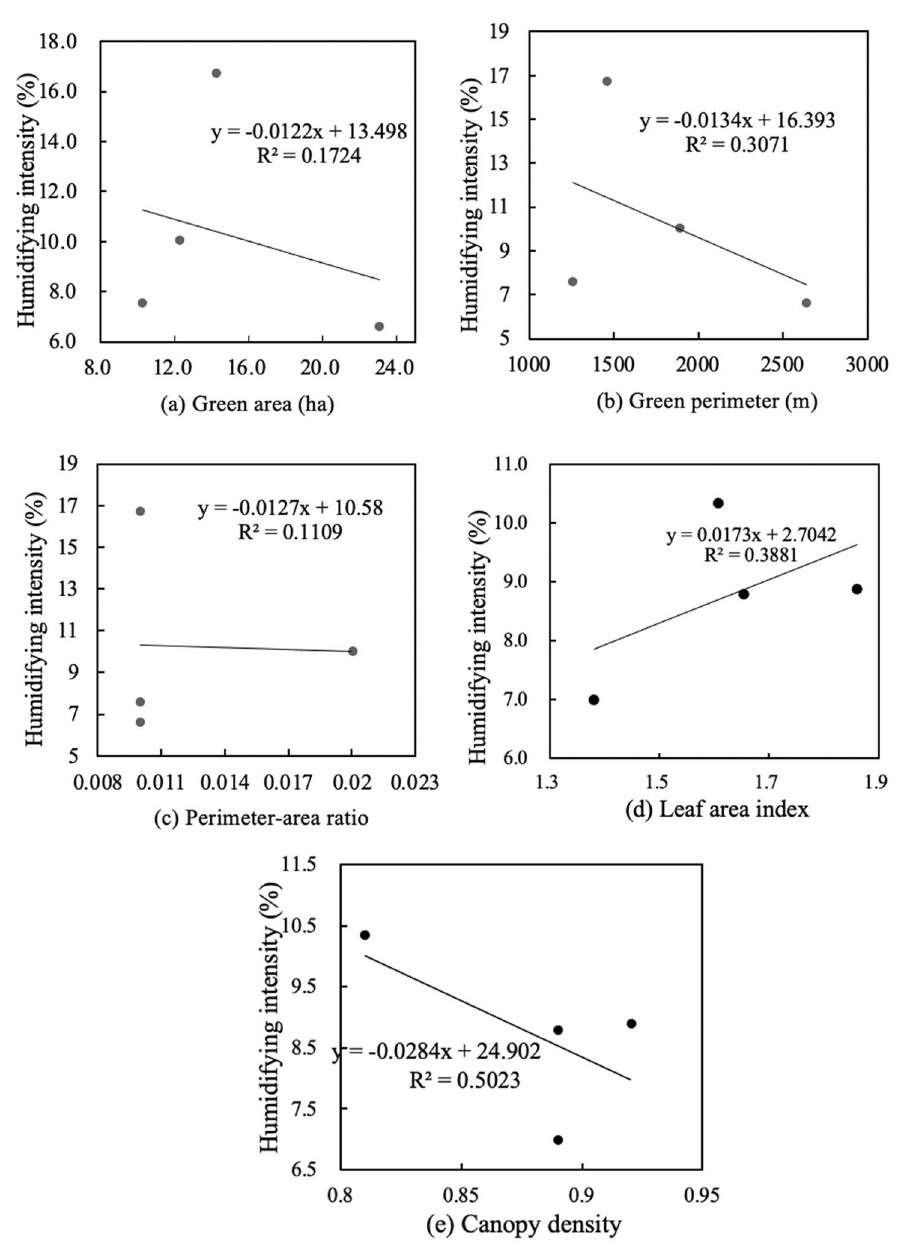
Figure 11. Linear regressions of spatial characteristics and humidifying intensity of large-size green